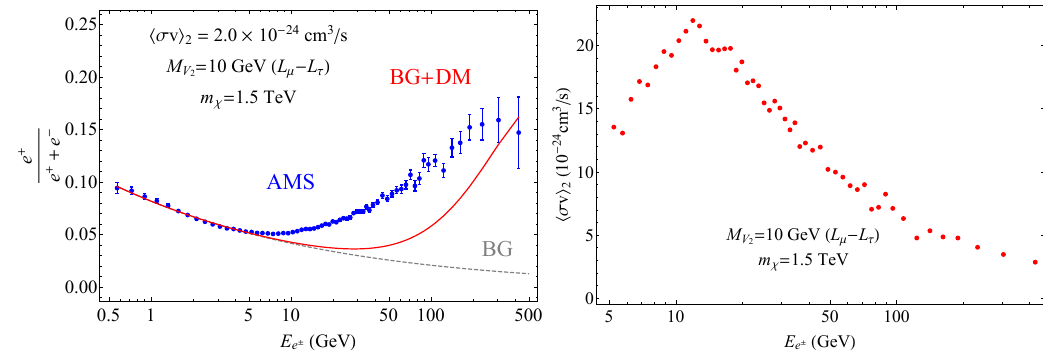
Figure 11 . Left panel: AMS positron fraction data [62] and the predicted value from the L (cid:22) (cid:0) L (cid:28) gauge boson. Here we use m (cid:31) = 1 : 5 TeV, m V = 10 GeV, and h (cid:27)v i 2 = 2 : 0 (cid:2) 10 (cid:0) 24 cm 3 /s for the DM 2 annihilation cross section. Right panel: 95% C.L. upper bound on h (cid:27)v i 2 from each AMS data point. (cid:12)t to the DAMPE data. As shown in (cid:12)gure 10, the Fermi constraints can be